Question: Provide a one-line summary of what is displayed.
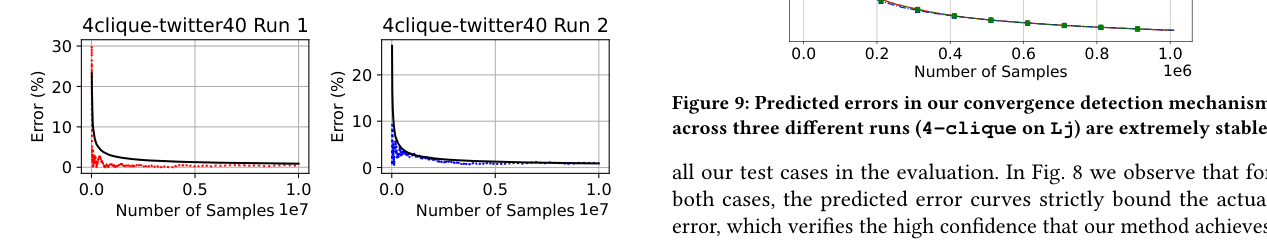
Answer: compares the error predicted by ScaleGPM-NS with the actual error throughout the sampling procedure, to show the ef- fectiveness of ScaleGPM-NS’s online convergence detection. We